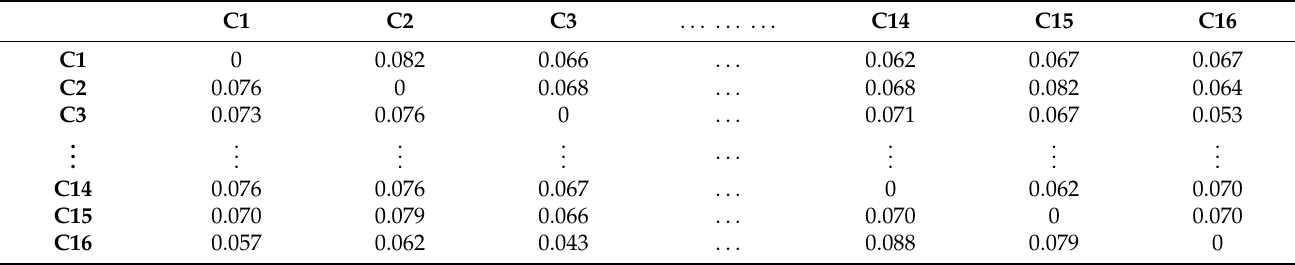
Table 10. Normalized direct relationship matrix (S).